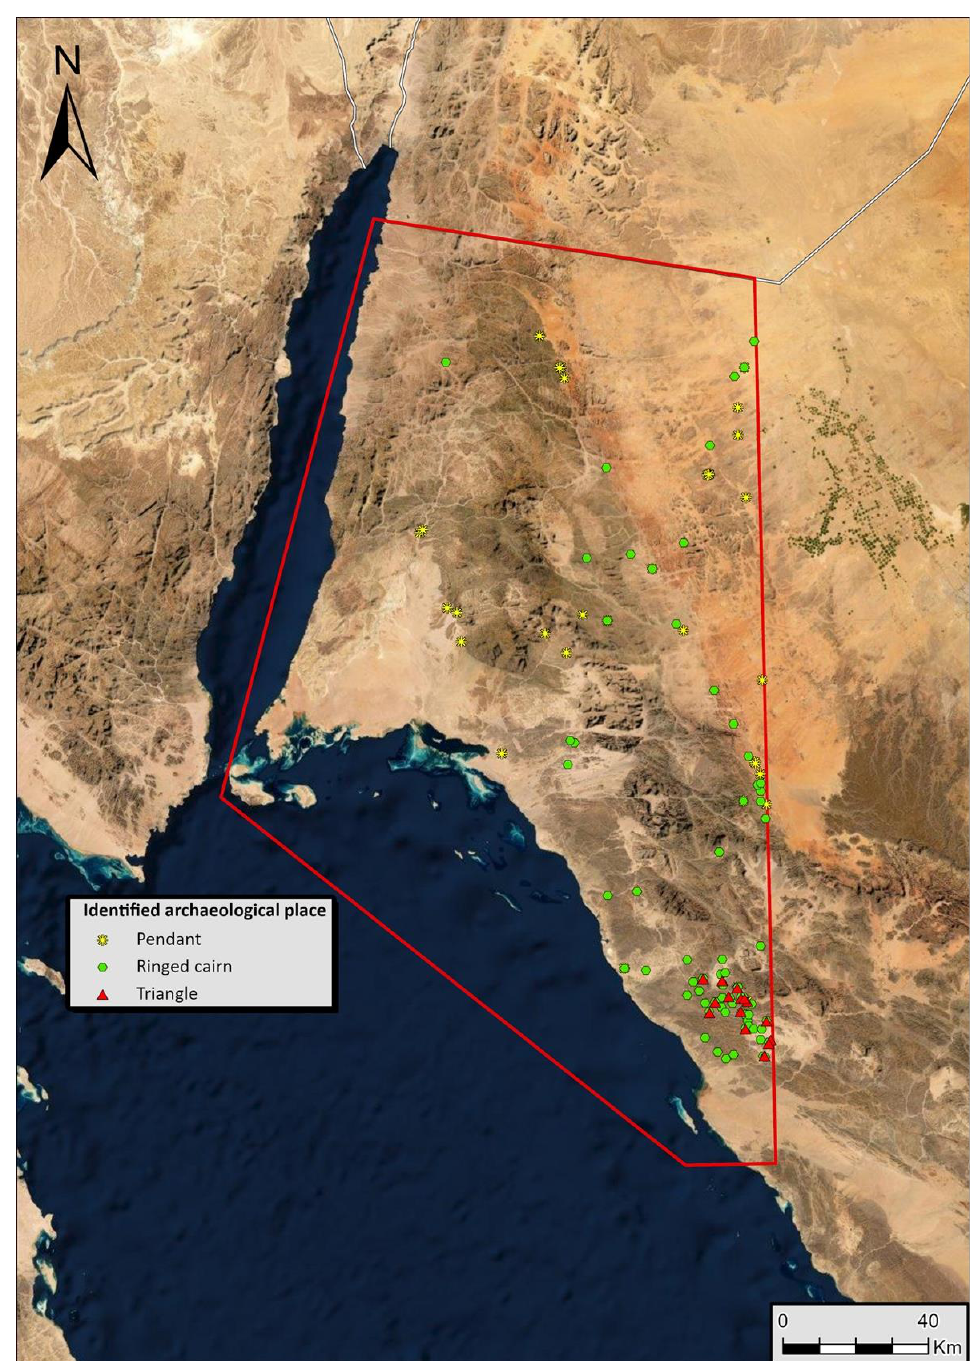
Figure 11. Distribution of ringed cairns, triangles and pendants.